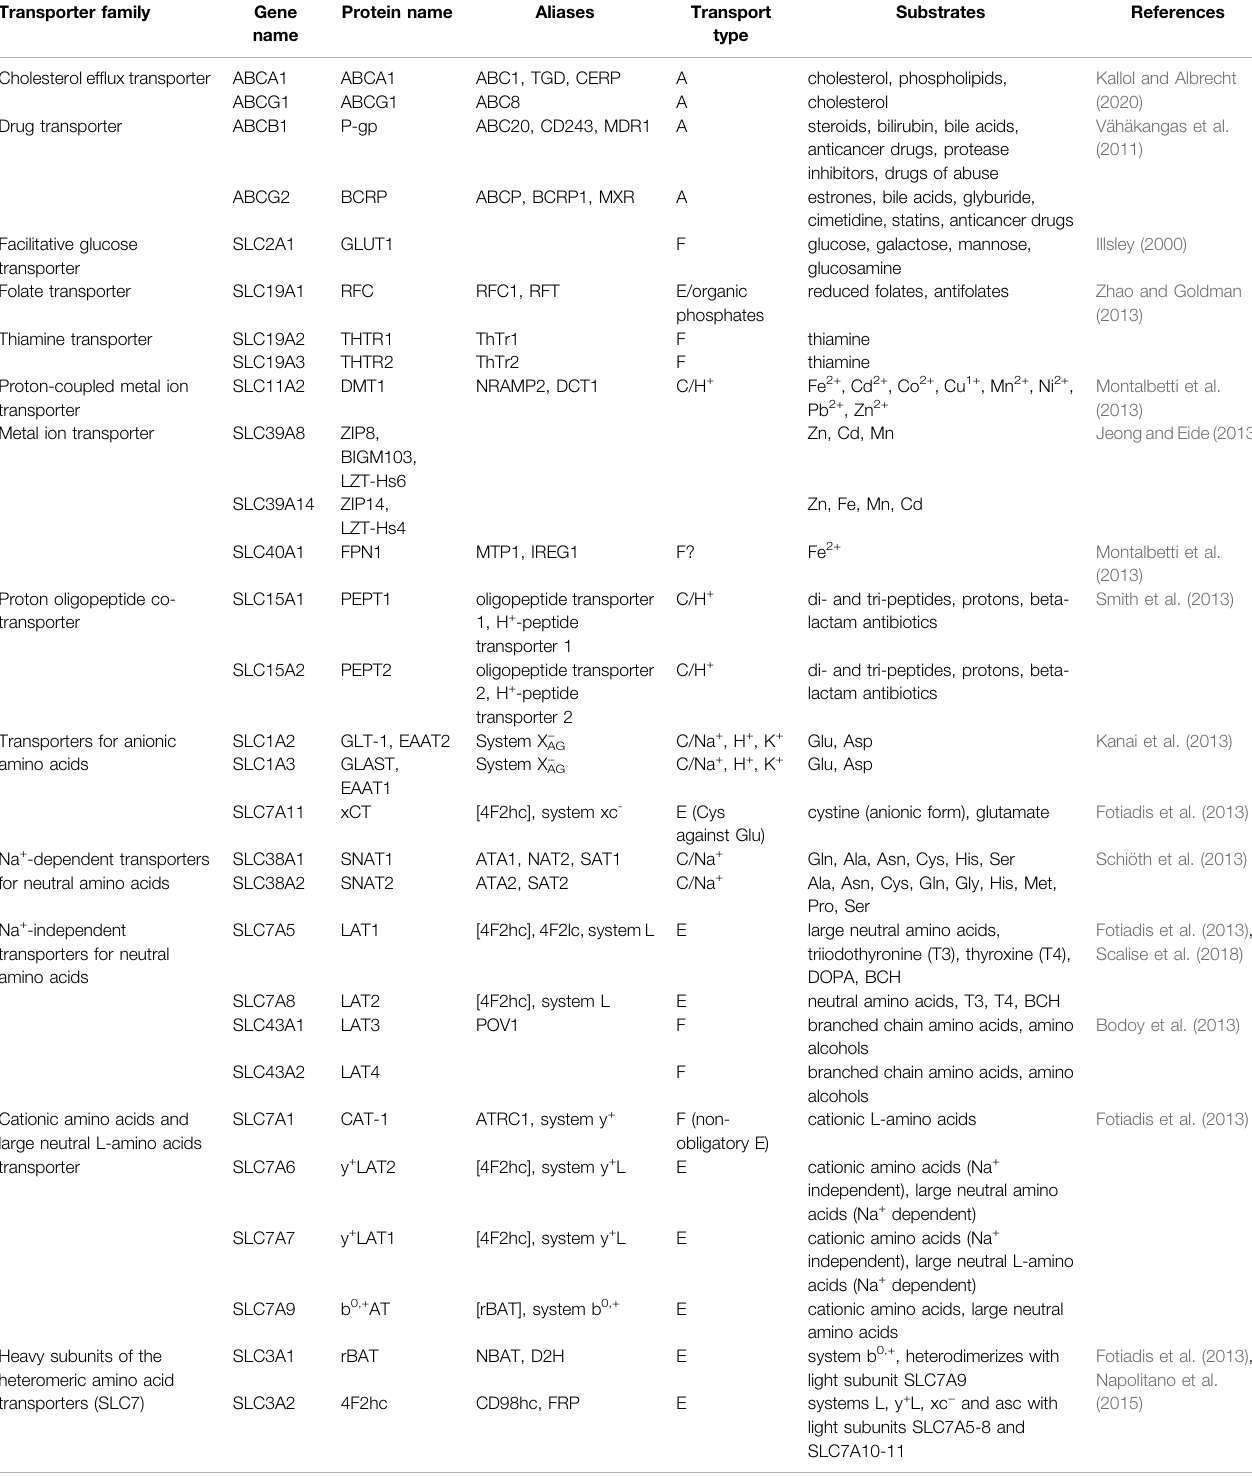
TABLE 1 | Overview of key placental ABC and SLC transport systems with associated genes and gene products, evaluated in the